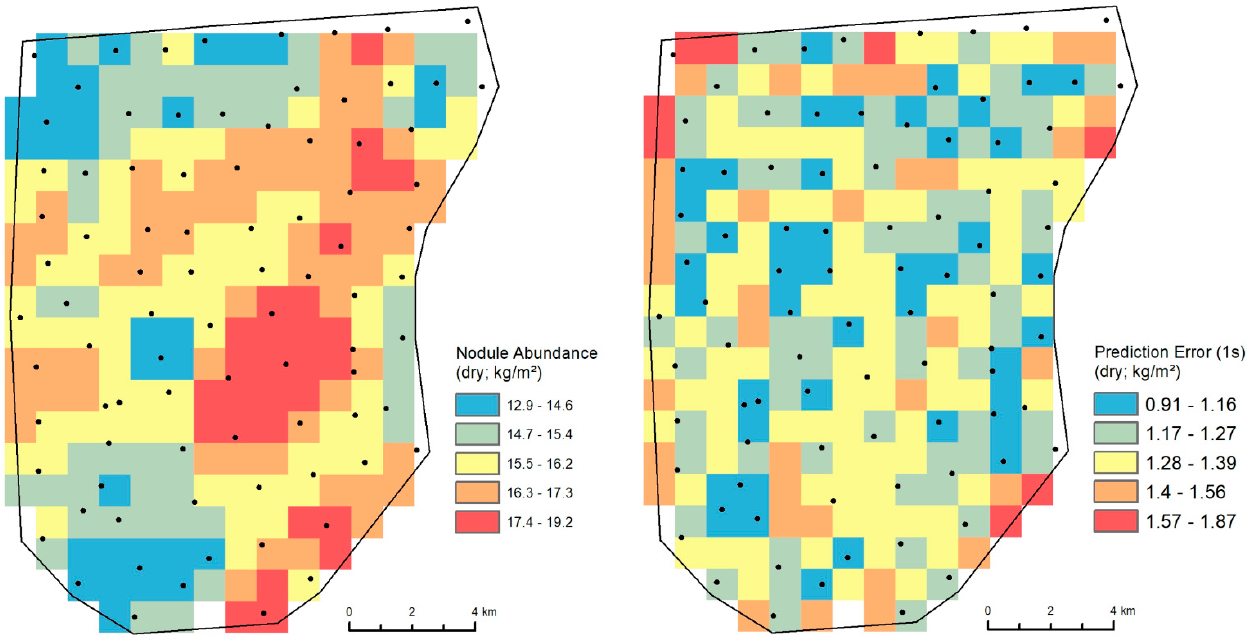
Figure 18. Prediction of nodule abundance in 1-km 2 blocks (1000 m × 1000 m) in PA1-West ( left ) based on ordinary kriging and the 1-sigma prediction error ( right ).